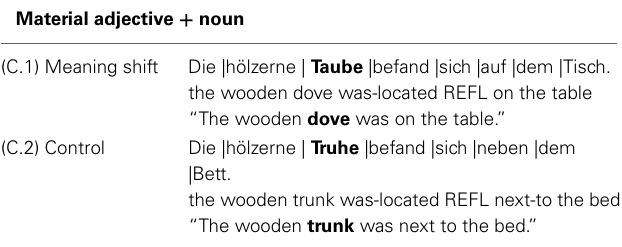
Table 3 | Sample stimuli for Experiment